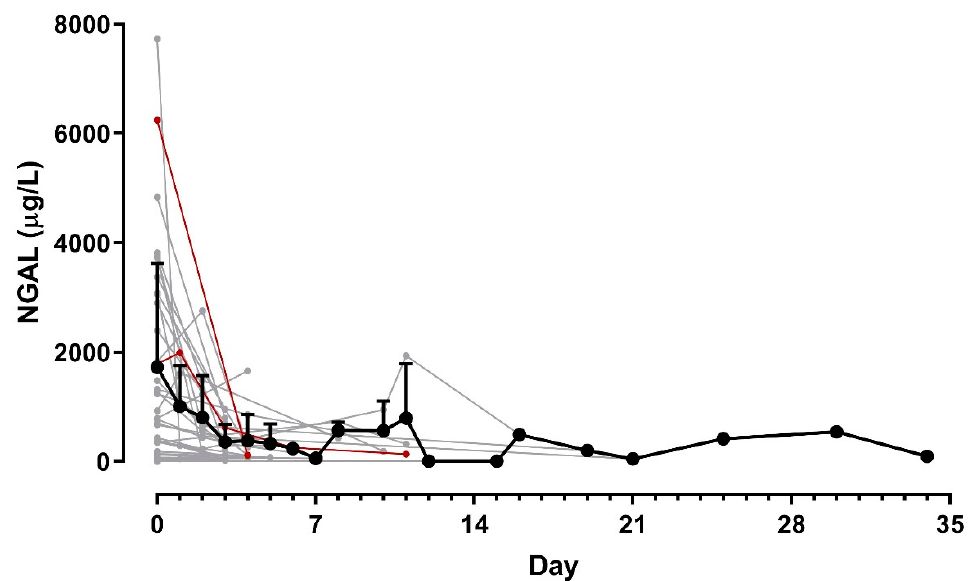
Figure 3. Concentrations of neutrophil gelatinase-associated lipocalin (NGAL) in synovial fluid obtained sequentially over the course of treatment of 35 horses suspected of septic synovitis. Samples were obtained at the attending clinician’s discretion, so with varying intervals, 1–34 days after initia- tion of treatment. Thin lines represent individual horses (grey = survivors [n = 33]; red = euthanized horses [ n = 2]), the bold black line represents average of all horses, error bars are standard deviations. To analyze the ability of NGAL to discriminate septic from non-septic, but also septic from uncertain and uncertain from non-septic, ROC curves were plotted (Figure 4, Table 2). The best threshold (cut-off) for distinguishing septic from non-septic was 293.6 µ g/L,